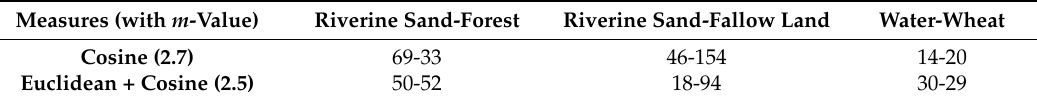
Table 6. The comparative results of the best single similarity measures and the composite measure while handling the mixed pixel containing two classes (membership value was calculated on 8-bit scale i.e., the target values for each class was 127.5, respectively).